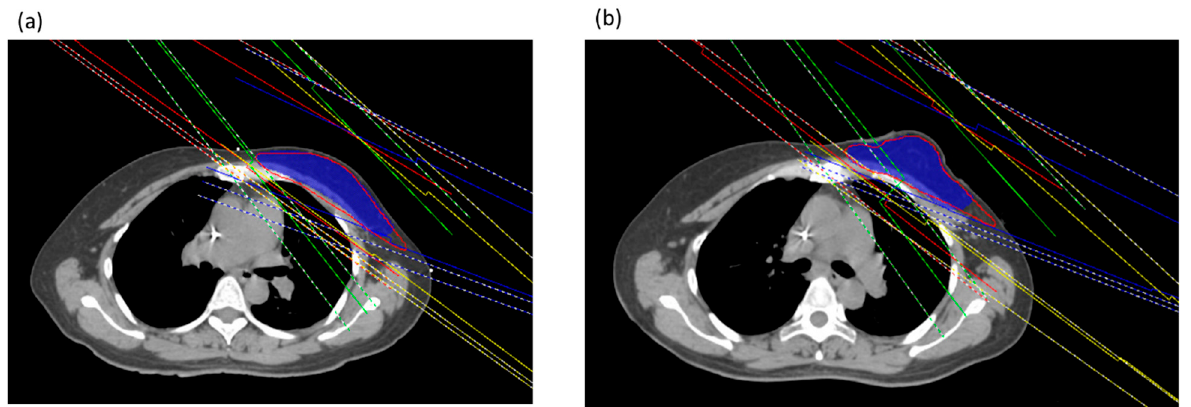
Figure 3. Beam arrangement between cases without ( a ) and with PERSBRA ( b ). The red line is the isodose line of 5000 cGy; the blue color is PTV. The beam arrangement was two tangential IMRT fields and two gantries tilted up 10–20° IMRT fields.